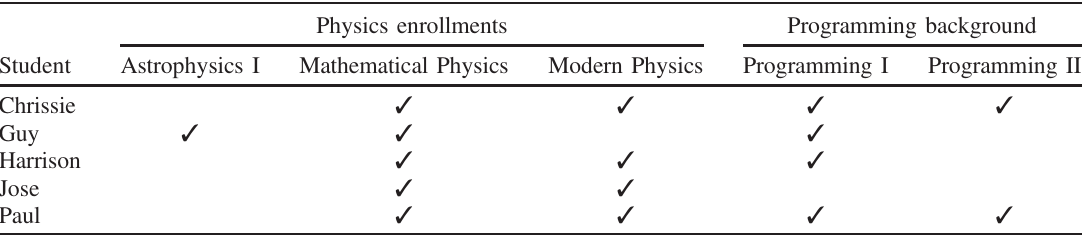
TABLE I. Summary of student interview